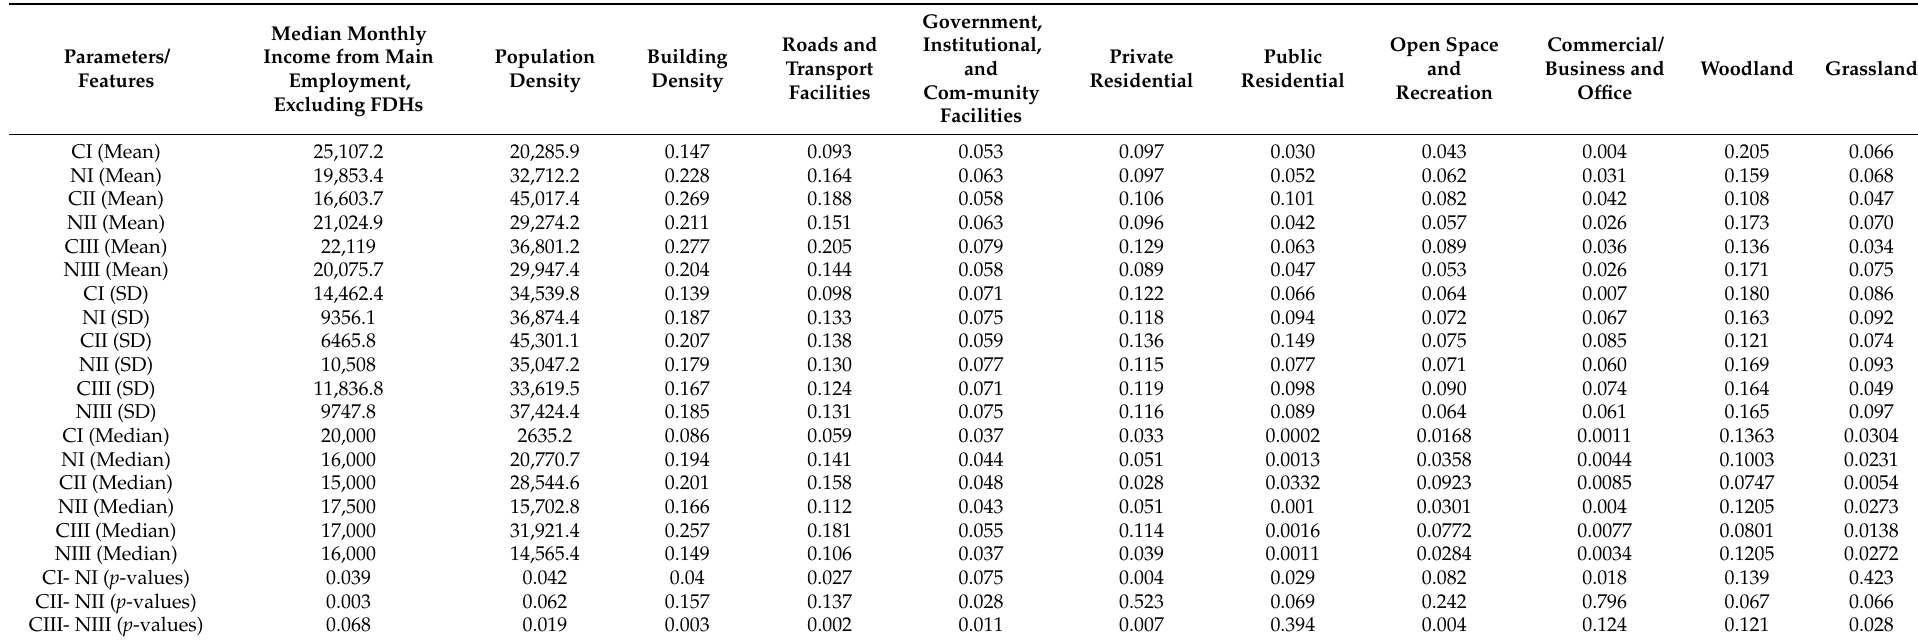
Table 9. Features’ distribution at different stages of residential location (“ p -value” is performed as asymptotic two-tailed significance of the Mann–Whitney test).